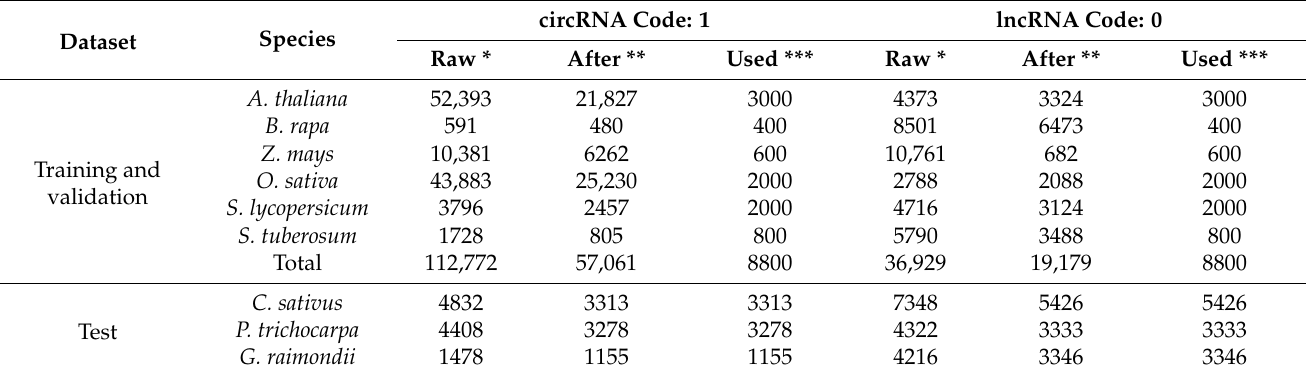
Table 12. Details of the datasets used in our